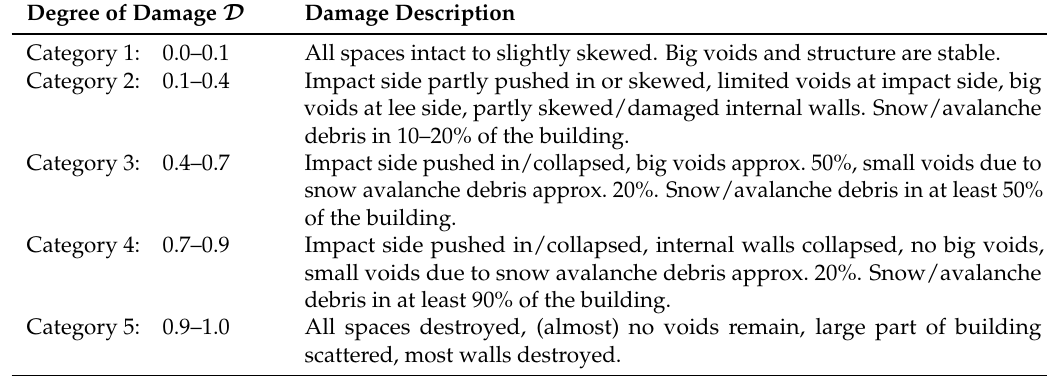
Table 4. Categorization of the degree of damage as proposed in